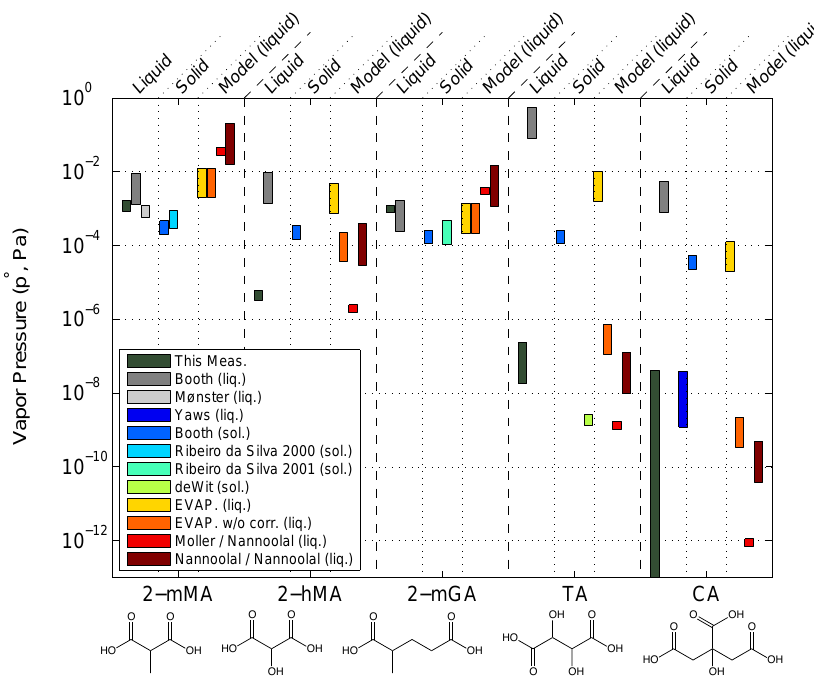
Fig. 2. Pure component vapor pressures at T = 298 . 15 ( p ◦ (T (cid:9) ) ) for 2-methylmalonic acid (2-mMA), 2-hydroxymalonic acid (2-hMA), 2- methylglutaric acid (2-mGA), DL-tartaric acid (TA), and citric acid (CA) – from this work (liquid) and from previous measurements reported in the liquid state, the solid state and the EVAPORATION model with and without empirical correction term as well as two commonly used models (all in liquid state). CA from this study is shown using the most conservative (largest) upper limit. Counter intuitively, the liquid vapor pressure measured here for 2-hMA, TA and CA is smaller than the solid-state vapor pressure reported by Booth et al. (2010). See Table 4 for full reference list.